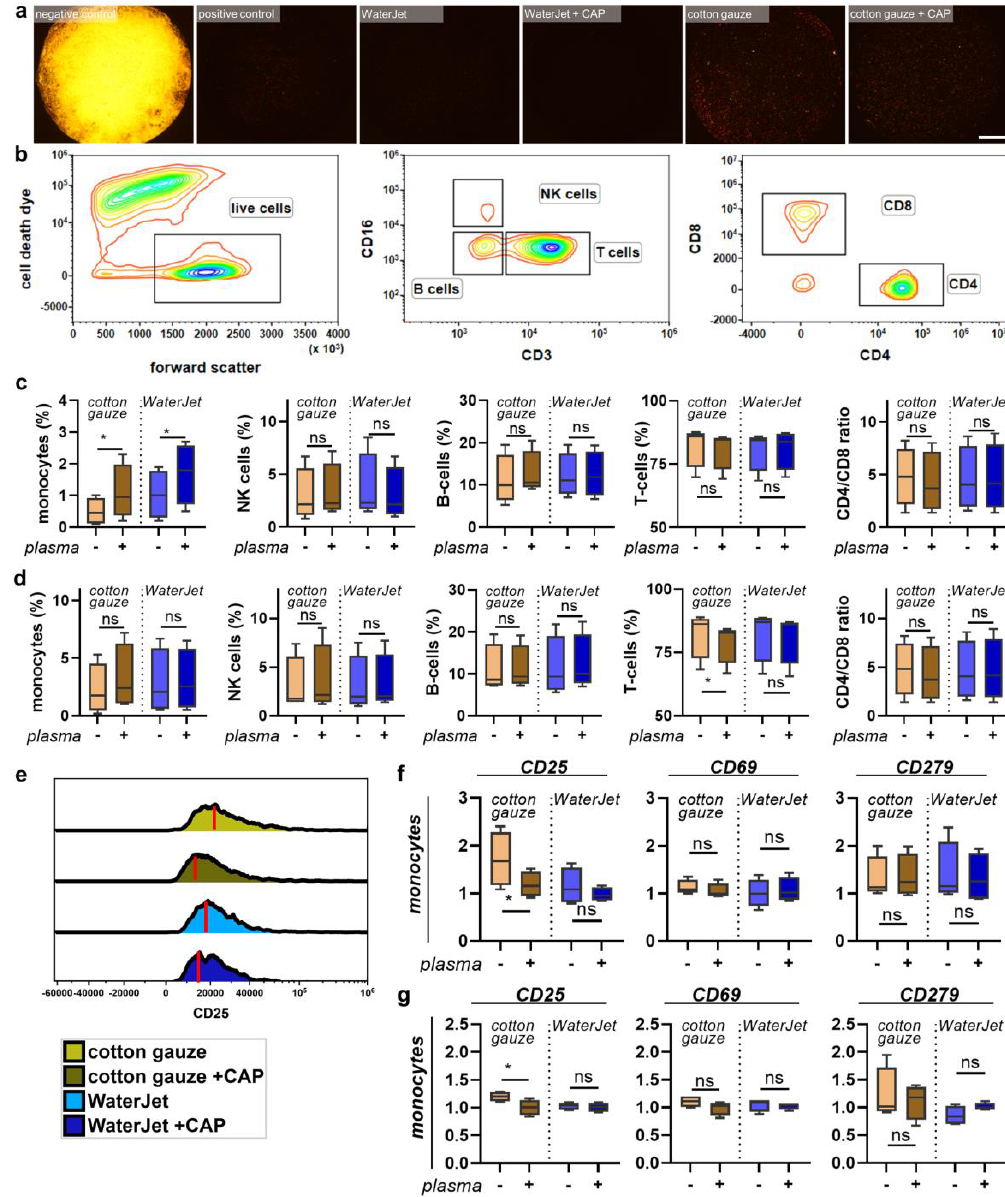
Figure 4. PBMC inflammation marker expression cultured with contaminated and clean, fixed titanium discs. ( a ) representative whole-well fluorescence microscopy images of acridine orange-stained biofilms after various treatments; ( b ) gating strategy showing discrimination of dead cells (left), lymphocyte subpopulations (middle), and T-cell subpopulations (right); ( c , d ) percentages of leukocyte subpopulations across all leukocytes cultured on contaminated (c) and clean, fixed titanium discs ( d ); ( e ) representative histogram overlays of the surface marker CD25 in monocytes with red lines indicating maximum channels; ( f , g ) surface marker expression of monocytes cultured on contaminated ( f ) and clean, fixed titanium discs ( g ). Data are from four donors and show boxplots and median of data normalised to untreated contaminated titanium discs ( f , g ). Statistical analysis was performed using paired t -test; * = p < 0.05, ns = not significant. Scale bar is 1 mm. PBMC from four different donors were tested. Biofilm was generated from subgingival plaque of a single periodontally diseased individual.